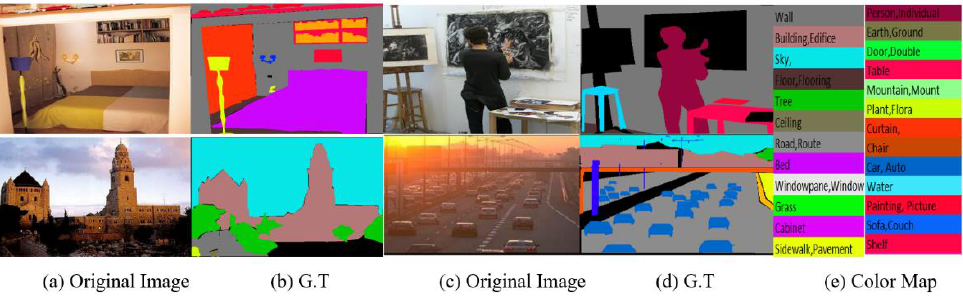
Figure 5. Image samples from ADEK 20K dataset. G.T stands for Ground Truth.